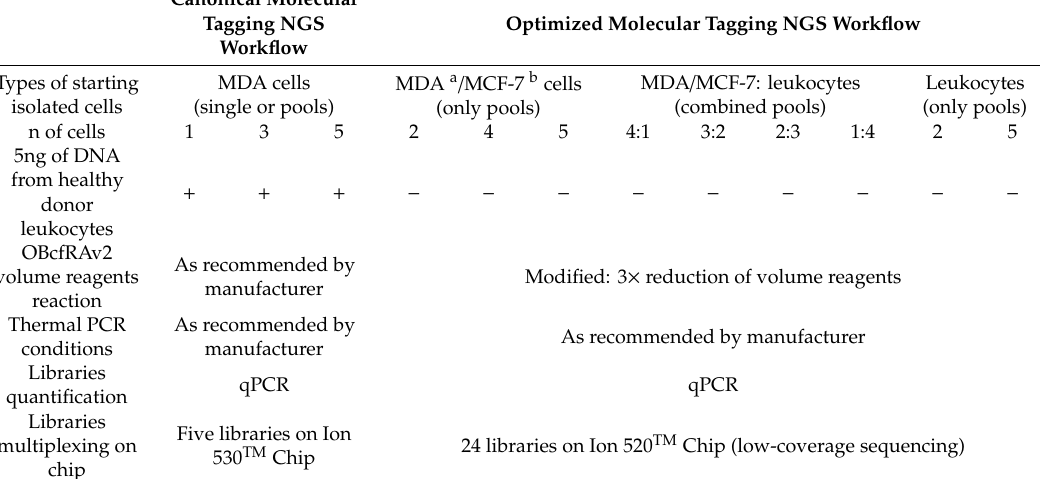
Table 1. Comparison between canonical and optimized molecular tagging Next-Generation Sequencing (NGS)